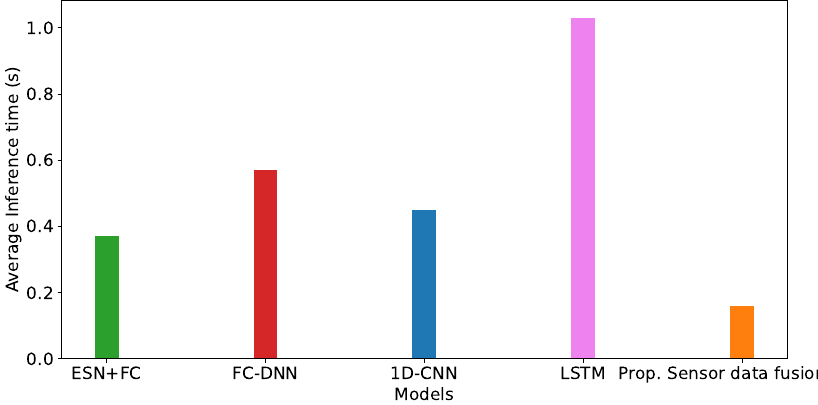
Figure 7. Models’ average inference